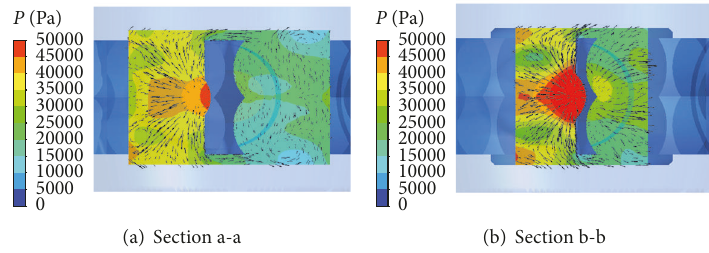
Figure 27: Static pressure distributions and absolute velocity vectors of Blade A ( 𝜃 ∗ = 36 ∘ , 𝑛 = 400 ,000 min −1 ).